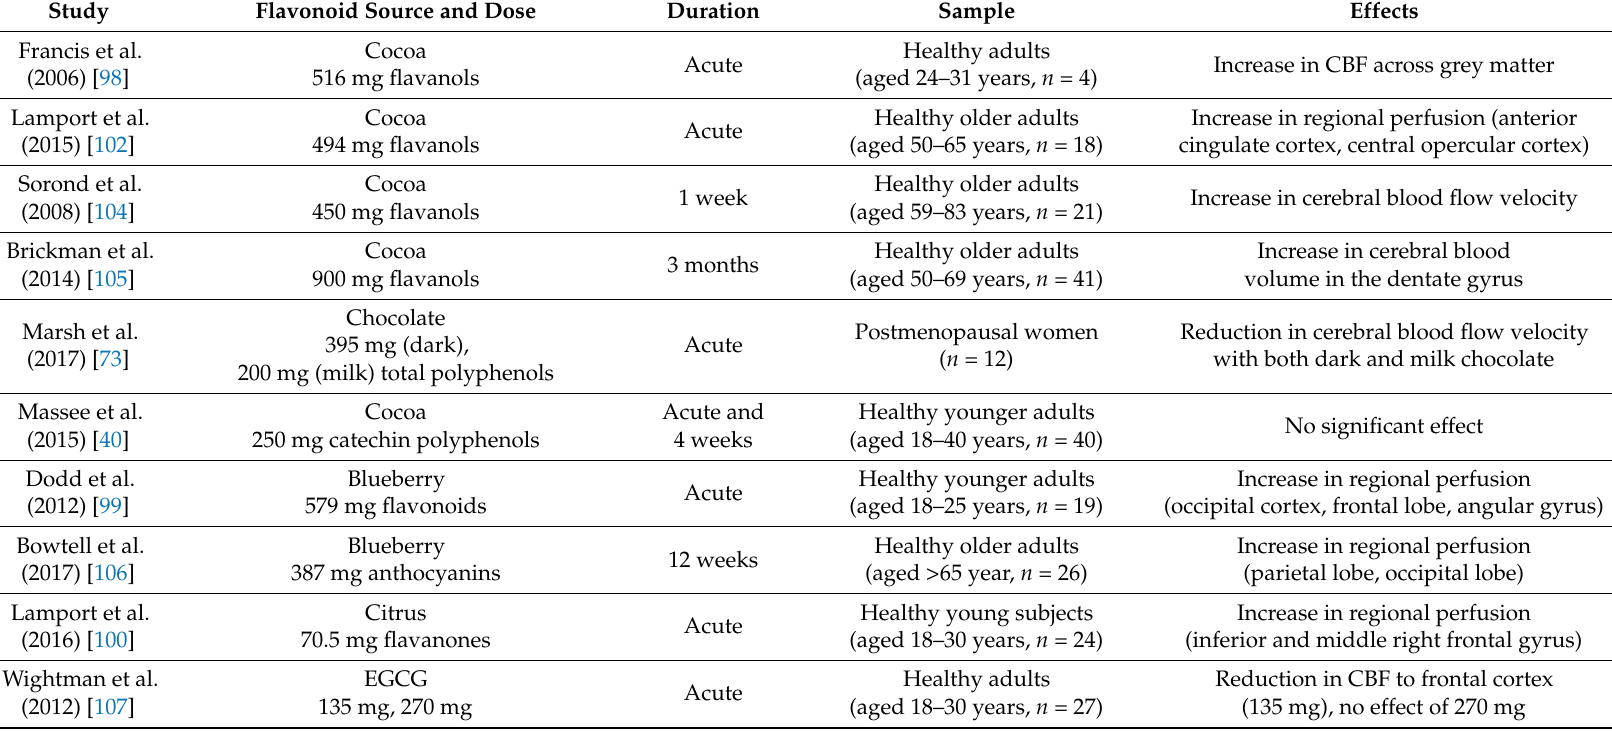
Table 3. Summary of studies investigating the effect of flavonoids on cerebral blood